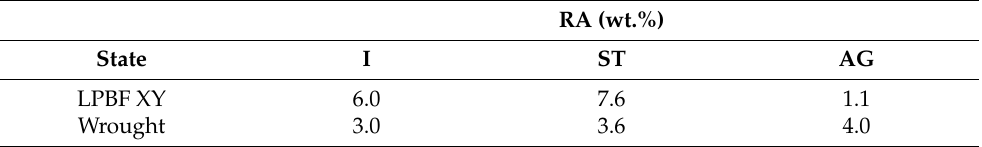
Figure 8. Phase distribution maps of the LPBF and wrought alloys: martensite is presented in blue and RA is presented in orange.